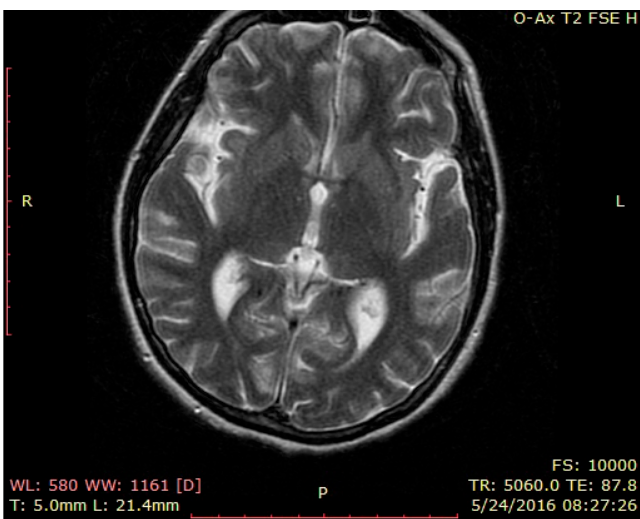
Figure 2. Brain MRI—normal findings (T2 weighted brain scan), axial insular image 1.